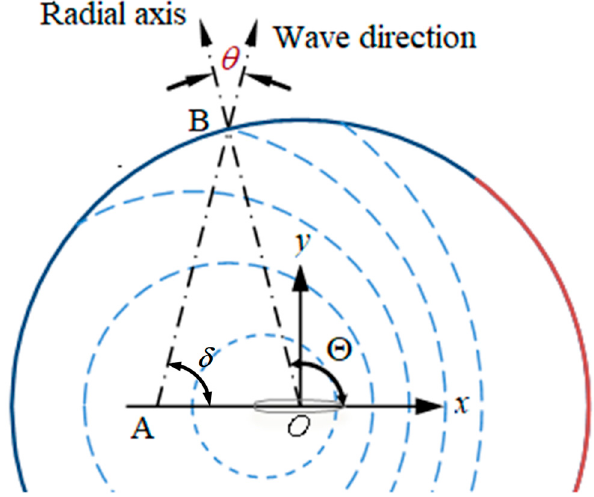
Figure 3. Illustration of b 2 -wave propagation.